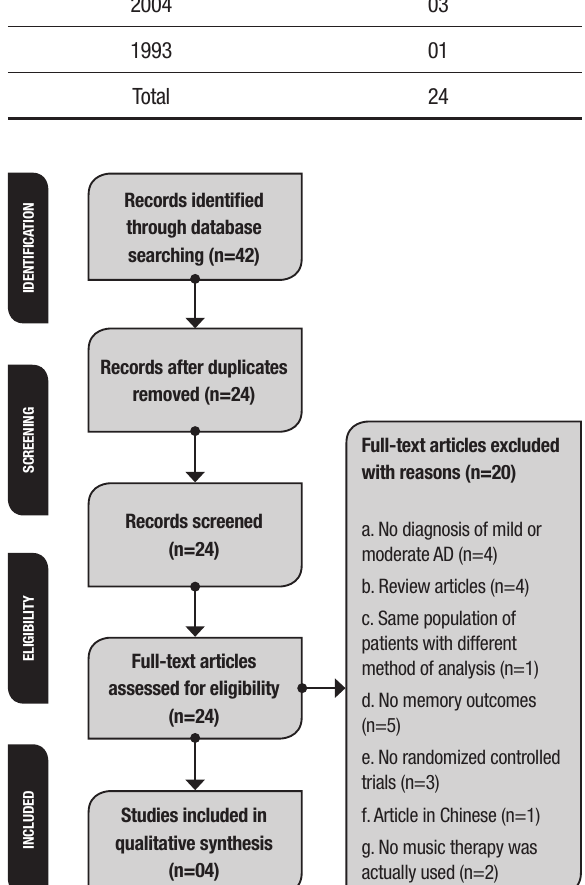
Figure 1. Systematic review flow diagram for the selection